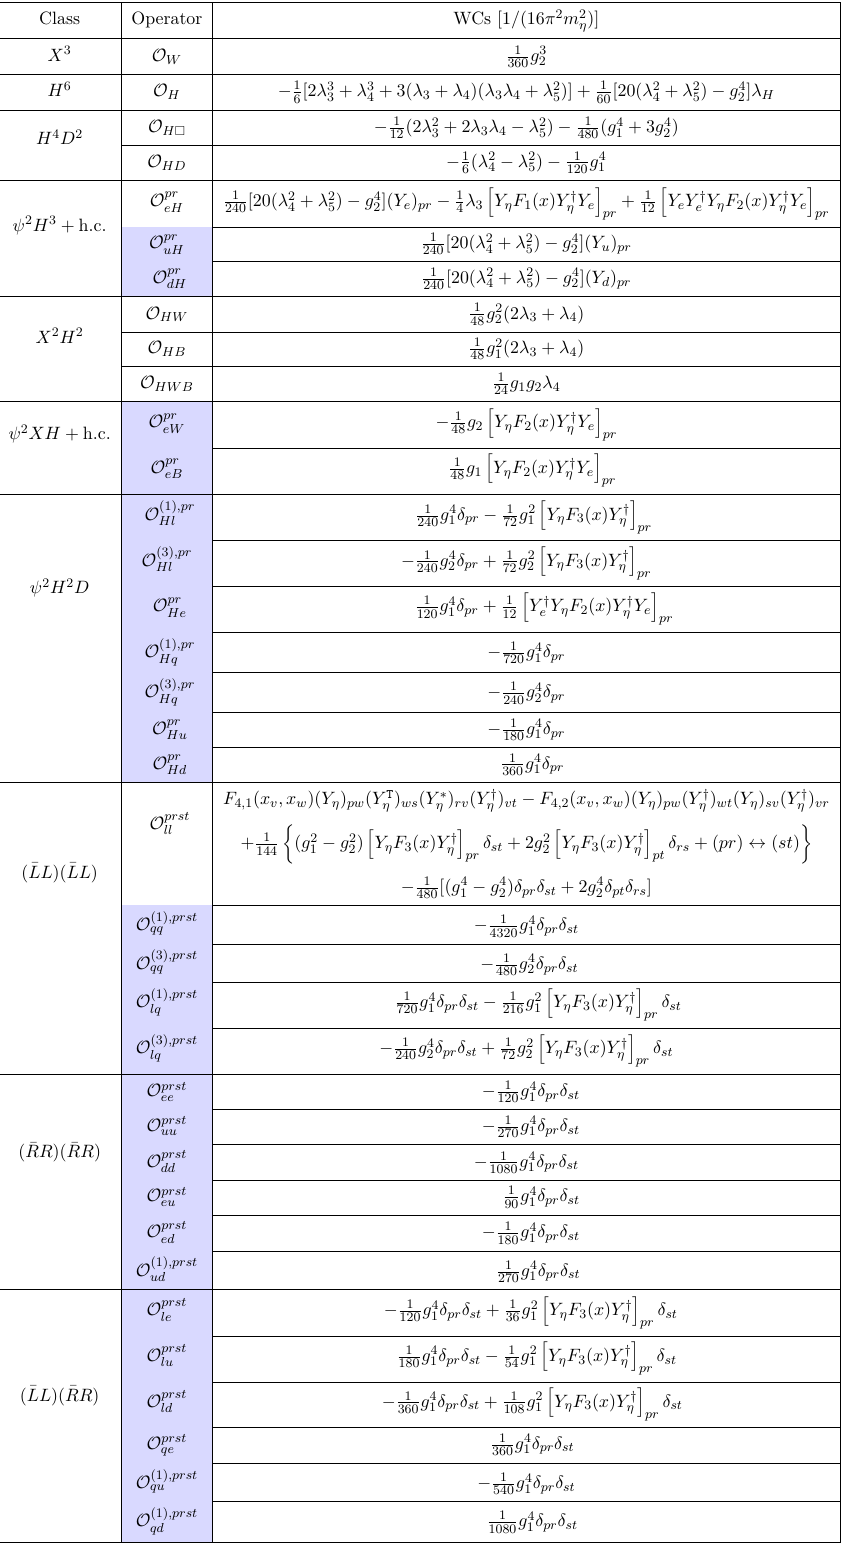
Table 2 . The matching result of dim-6 operators in the standard basis